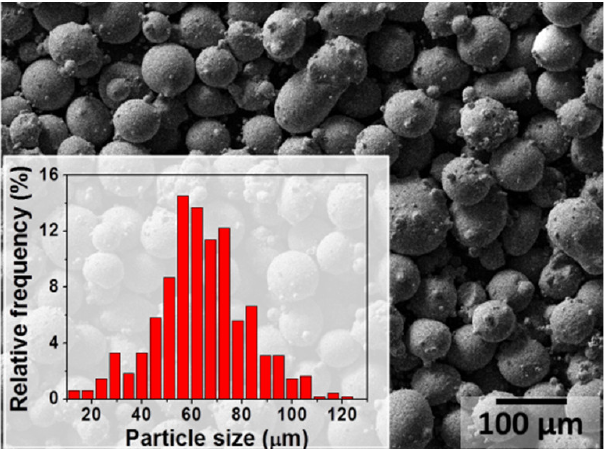
Figure 1. Secondary electron image of the 316L stainless steel powder used to print the samples together with the particle diameter distribution. Table 1. Composition of 316L stainless steel in wt.% with balance of Fe.